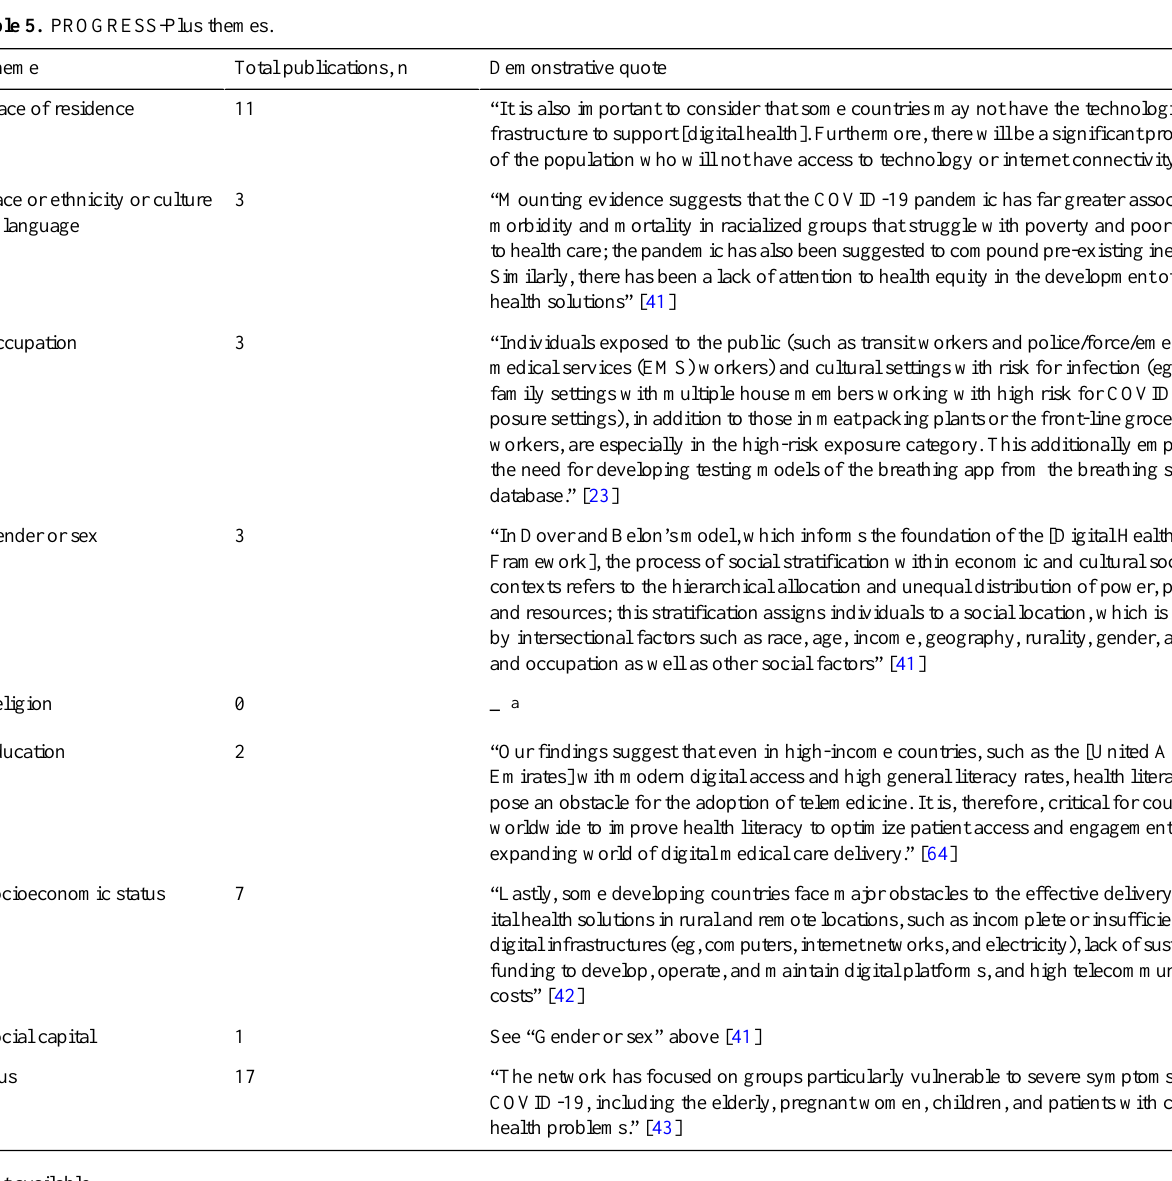
Table 5. PROGRESS-Plus themes.